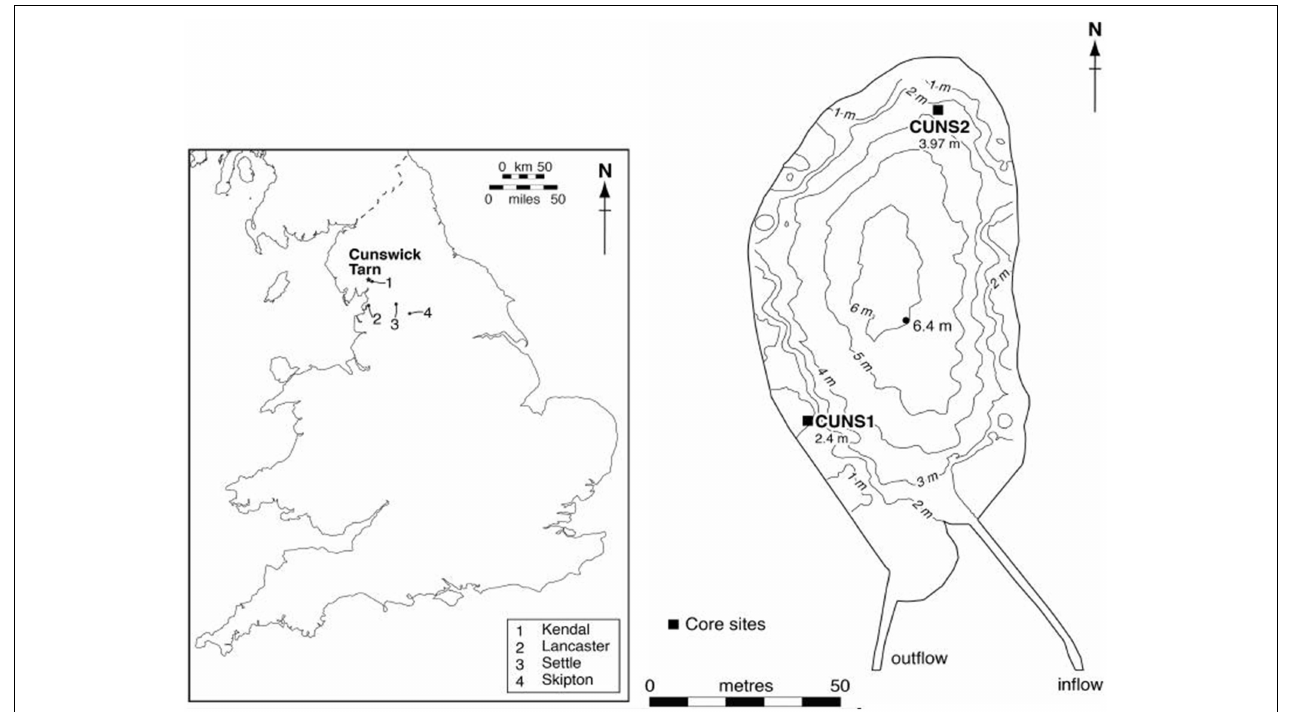
FIGURE 1 | Cunswick Tarn location and bathymetry, showing the core collection sites and water depths.